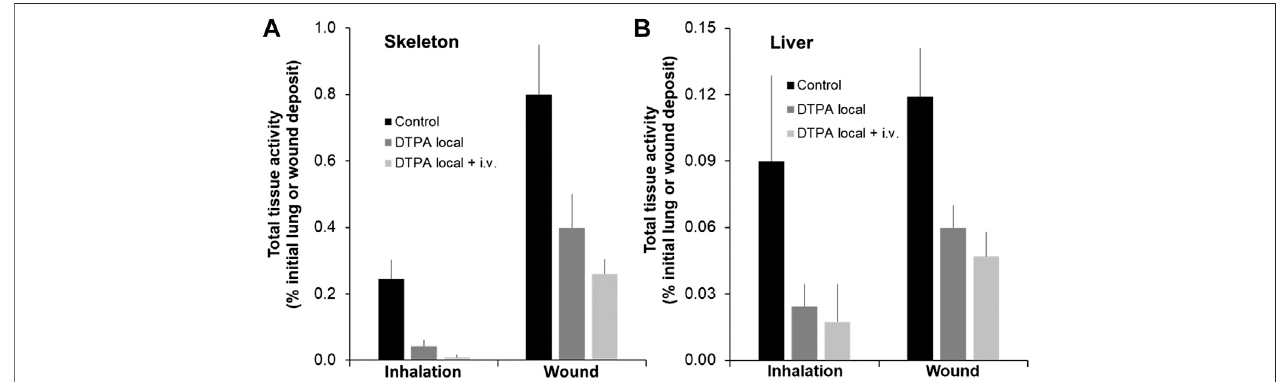
FIGURE 6 | Effect of local DTPA or local DTPA followed by DTPA systemic administrations on skeletal (A) and liver (B) total activity levels following lung or wound contamination with MOX. Animals were contaminated by MOX inhalation (12 kBq) or deposition in a wound (13 kBq) as described. Local administration to lungs (DTPA powder about 5 µmol/kg) or wound (DTPA solution 30 µmol/kg) was started at 2 h ( “ Local ” ). For combined local and systemic DTPA treatment ( “ Local + i.v. ” ) animals received the local dose at 2 h then two intravenous DTPA injections per week from day one to day 20 (30 µmol/kg). Rats were euthanized 21 days following